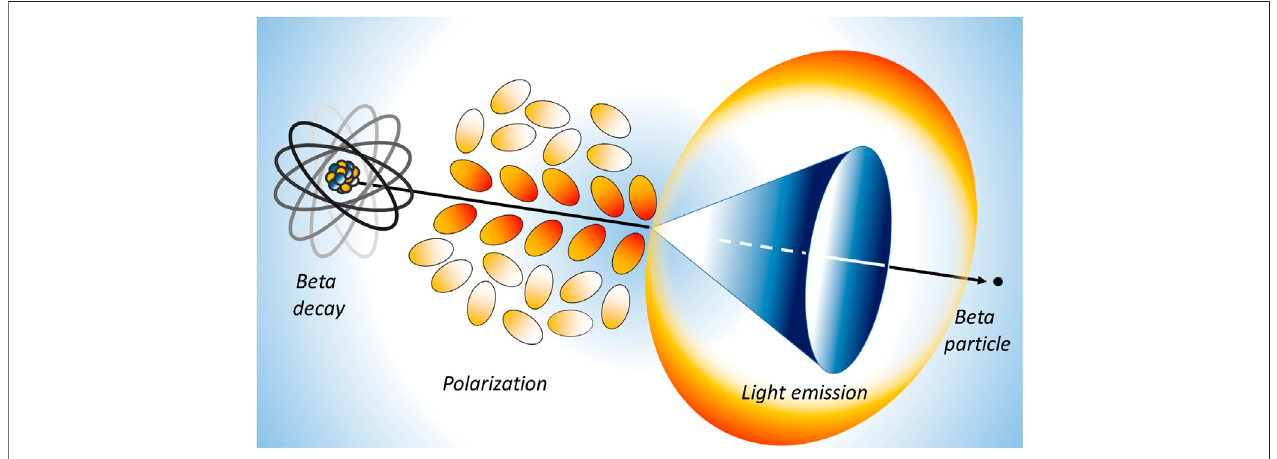
FIGURE 3 | Schematic representation of the Cerenkov light emission process. A beta particle, emitted by a radionuclide, travels in a medium faster than the light speed in the medium itself. The fast de-polarization of the molecules produces a cone of light known as Cerenkov